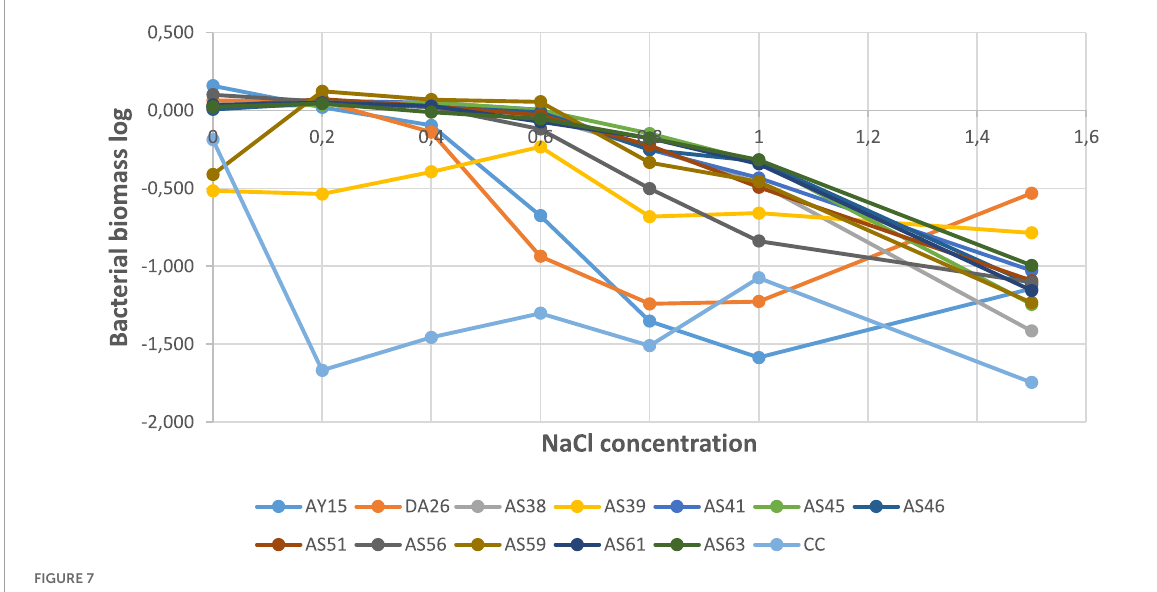
FIGURE7 Biomass in function of salt concentrations g/L.